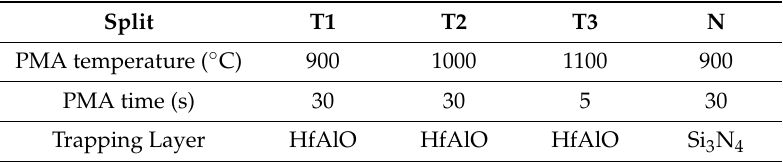
Table 2. SAHAOS devices prepared with various PMA